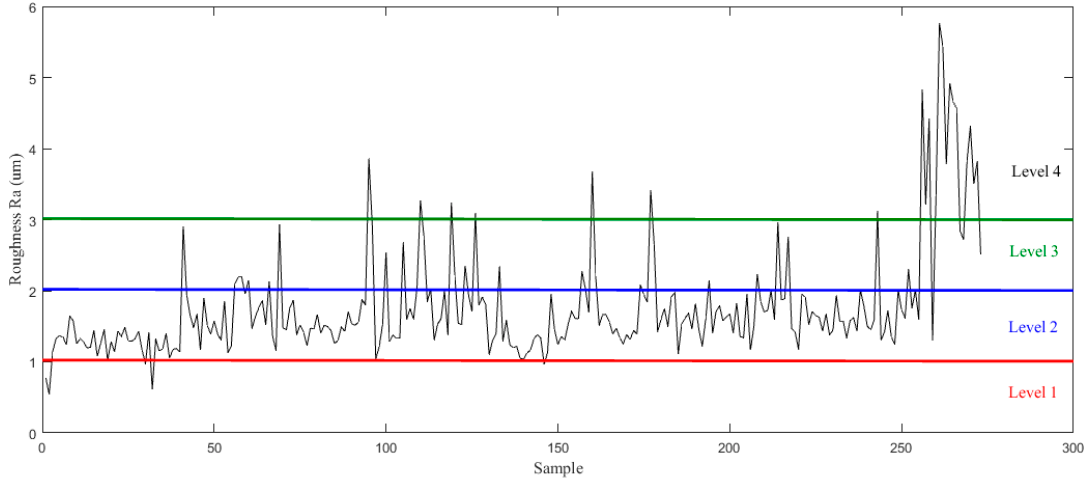
Figure 5. Roughness curve.